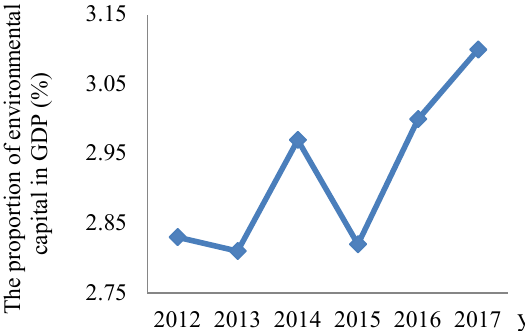
Figure 2. The change of proportion of environmental governance capital in GDP of Shanghai.